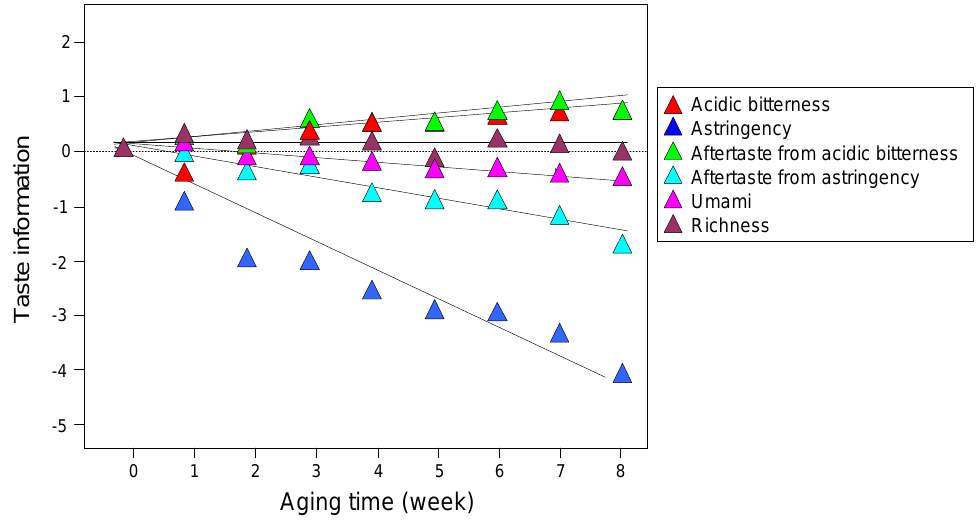
Figure 19. Change in taste qualities for green tea with aging. All green tea samples were stored in a temperature bath at 60 °C for up to 8 weeks (Adapted from